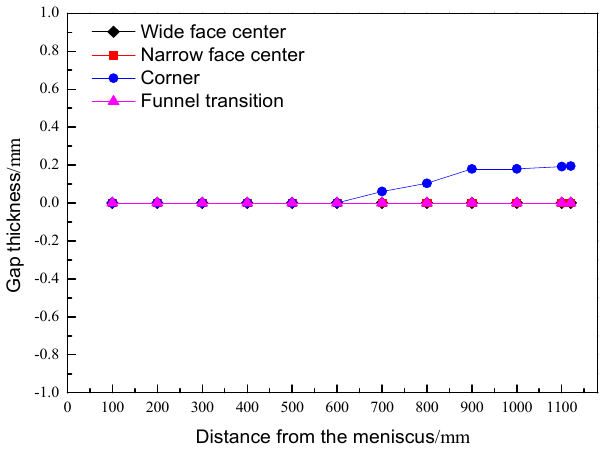
Figure 5. Gap distribution along the drawing direction at typical locations.